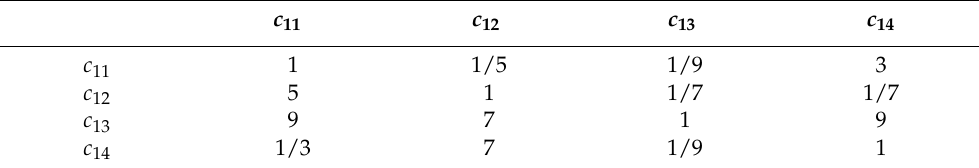
Table 5. Matrix for pairwise comparison of the sub-criteria of the technological conditions.